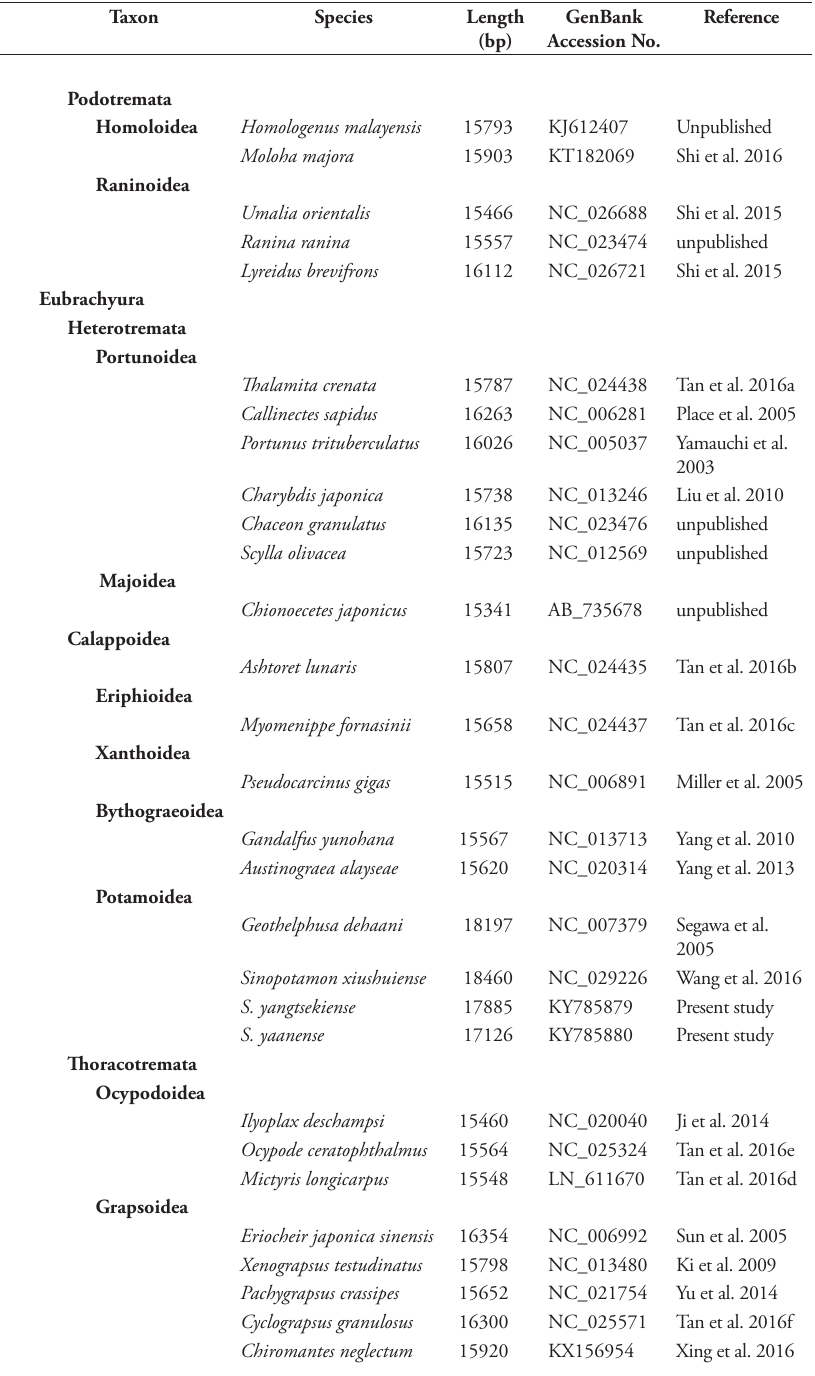
Table 1. Taxon sampled and its mitogenomic information used in this study. Taxon Species Length